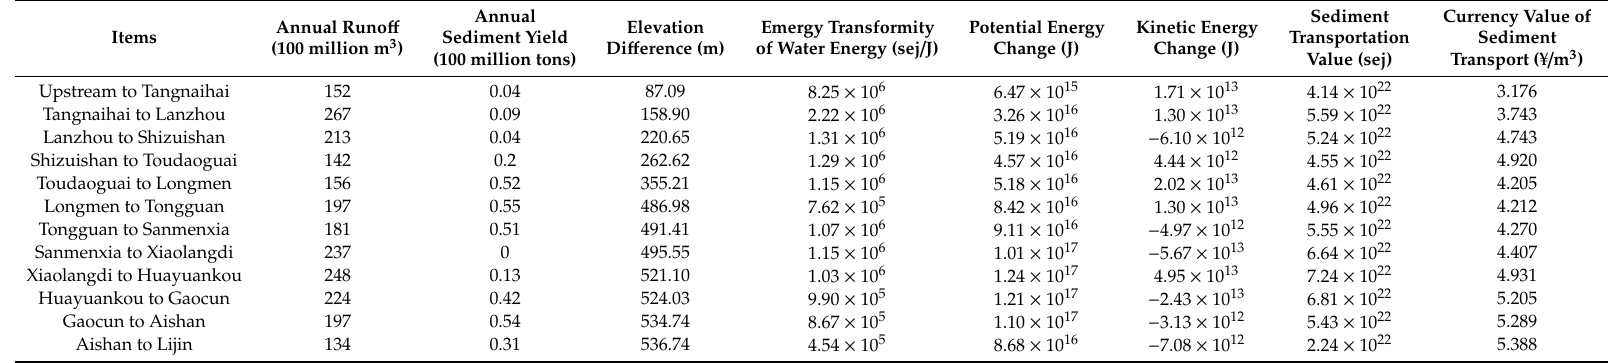
Table 5. Sediment transportation values of sections of the Yellow River